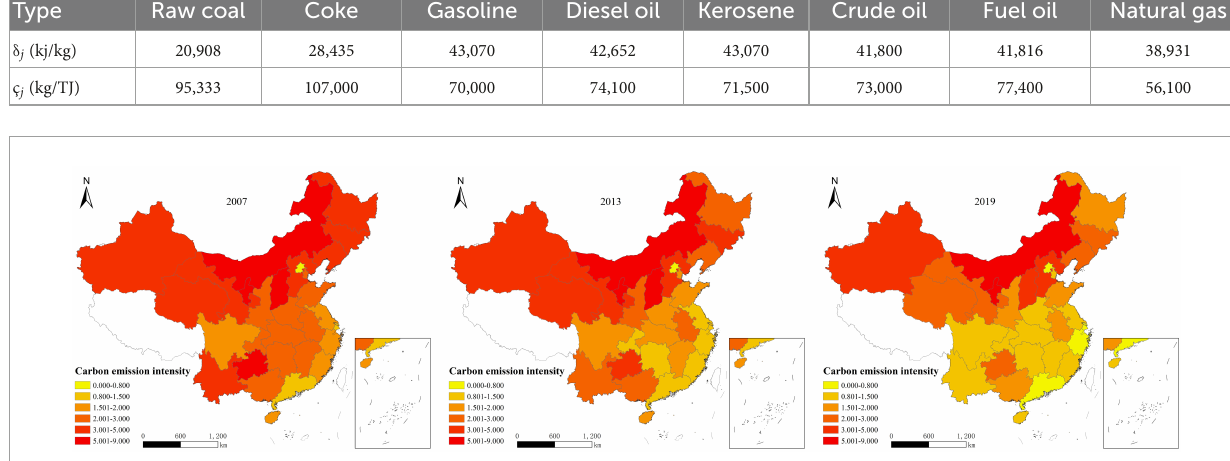
likely to affect carbon emission intensity. Foreign direct investment direct investment to real GDP. Openness to the outside ( open